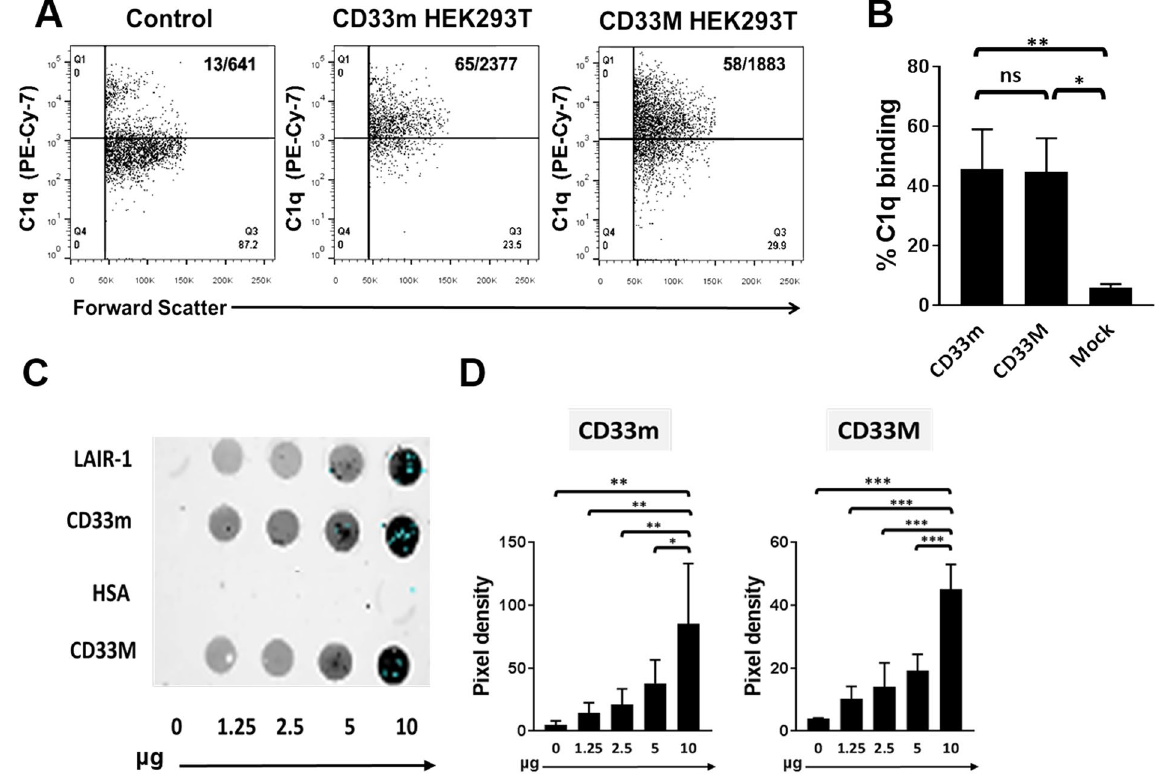
Figure 2. C1q binds to CD33M and CD33m isoforms on the cell surface. ( A ) A representative flow cytometry plot showing binding of biotin C1q (20 ug/ml) to HEK293T cells transfected with plasmids encoding CD33m and CD33M and control mock plasmid. Cells were incubated with C1q as outlined in Materials and Methods. Numbers in graphs = % positive/MFI. Debris/dying cells was excluded on the basis of forward and side scatter. ( B ) Pooled flow cytometry data illustrating binding of C1q (at comparable levels) on the surface of CD33m/M transfected HEK293T cells and a lack of C1q binding on mock transfected cells. For A and B, N = 3. ( C ) Representative slot blot showing that C1q binds to cell-associated CD33m, CD33M or LAIR-1 in a dose dependent manner. Protein prepared from whole cell lysates (HEK293T cells transfected with plasmid encoding CD33m, CD33M or LAIR-1) was immobilized on membranes at increasing doses; biotin-whole C1q was in solution at 10 ug/ml. HSA = human serum albumin control. Protein concentration was calculated by the BCA method. Bound proteins were detected using streptavidin conjugated Infrared 800 (LI-COR). ( D ) Pooled data analyses illustrating dose related interactions between biotin-C1q and cell-associated CD33m or CD33M represented in ( C) . ( B , D ), the mean ± SE of pooled data is shown; for all proteins and doses, N = 3–5. * P = < 0.05, ** P = < 0.01, *** P < 0.001. One-way ANOVA followed by Tukey’s pairwise multiple comparison was